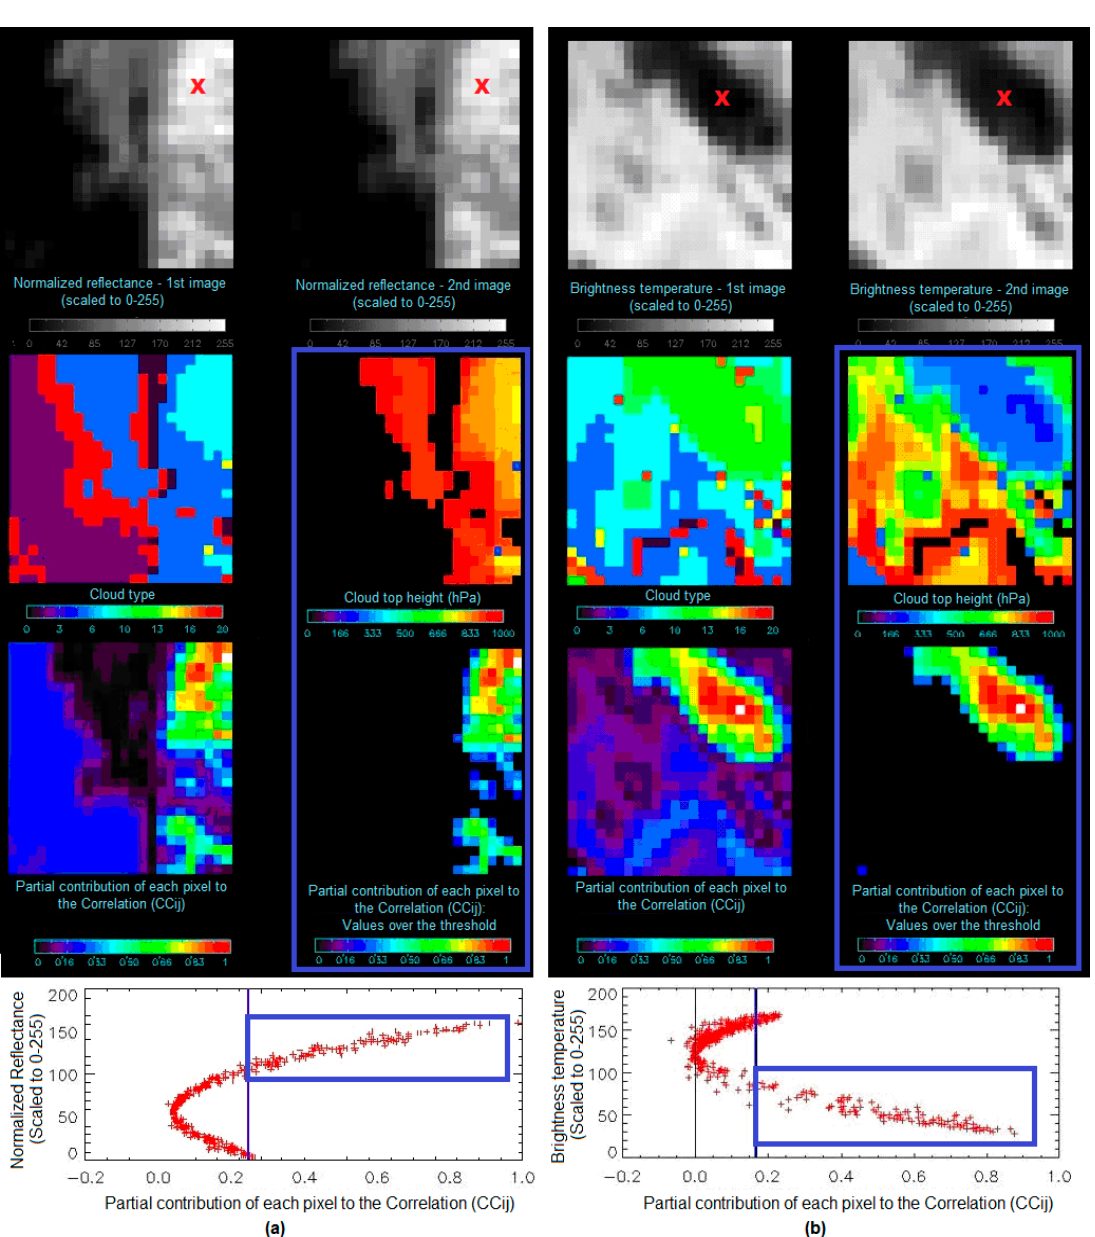
Figure 7. Matrices and graphs used in the calculation of CCC method height assignment, for a MSG / VIS08 case ( a ) and a MSG / IR108 case ( b ), as explained in the text. Pixels and graphs actually used for the calculations of P CCC and ∆ P CCC are those included in the blue squares. The weighted location used for the calculation of the AMV displacement between the initial image and the later image is also shown as a red cross in the images in the first row.